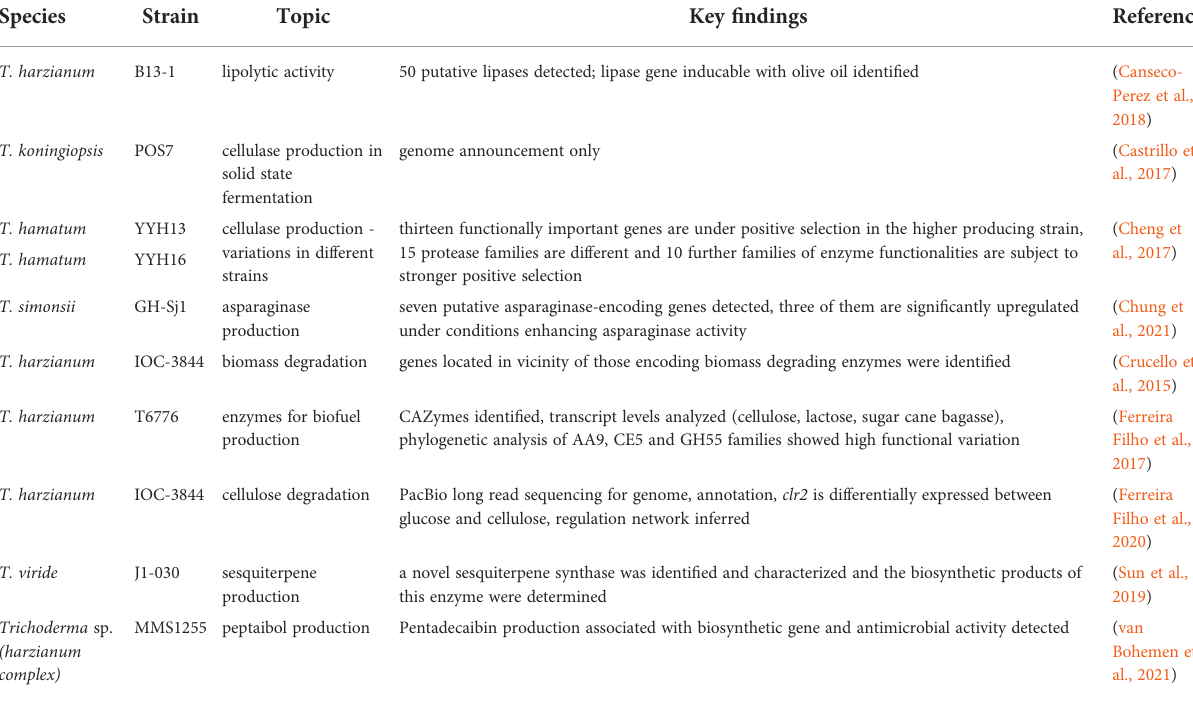
TABLE 2 Recent genome level analyses of Trichoderma spp. targeted at bioprospecting of enzymes and bioactive compounds. Species Topic Key fi ndings